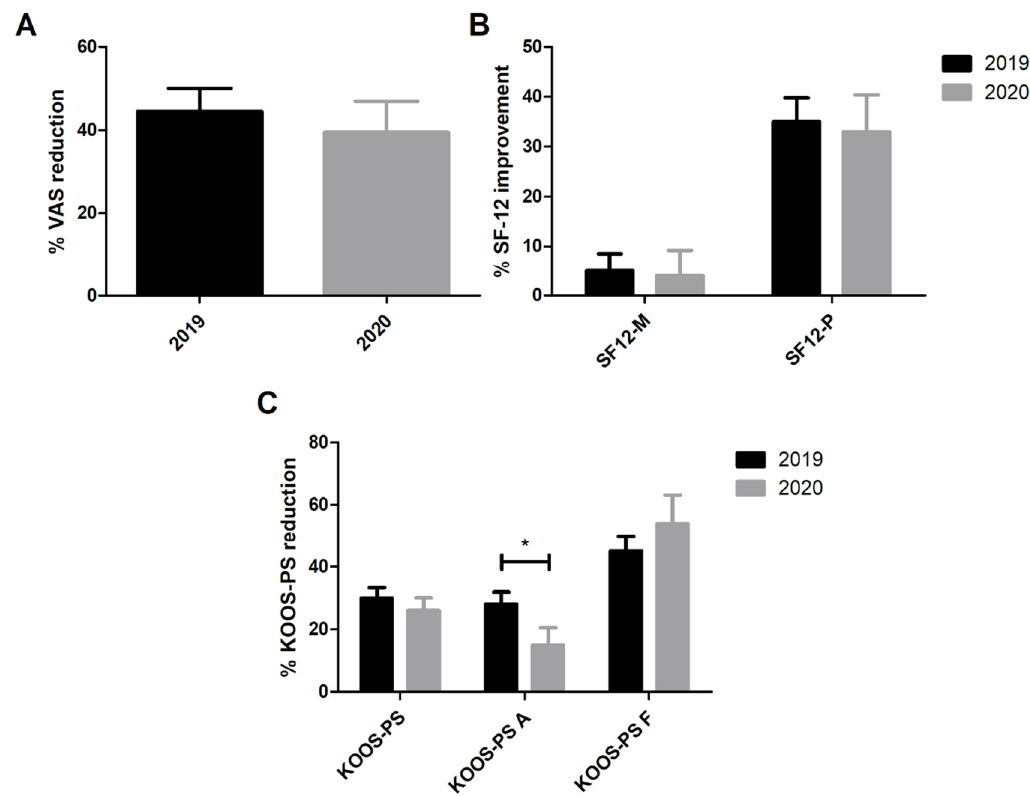
Figure 3. VAS ( A ), SF-12 ( B ) and KOOS-PS ( C ) percentage improvements in patients treated for TKA in 2019 and 2020. * p < 0.05. Data expressed as mean ± SEM. Table 3. PROMs in TKA patients.